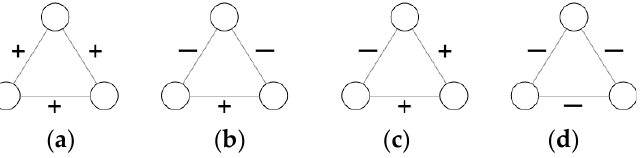
Figure 1. Balanced and unbalanced triangles. “+” means a positive edge, “ − ” means a negative edge, where sub-figures ( a , b ) are balanced triangles and ( c , d ) are unbalanced triangles.